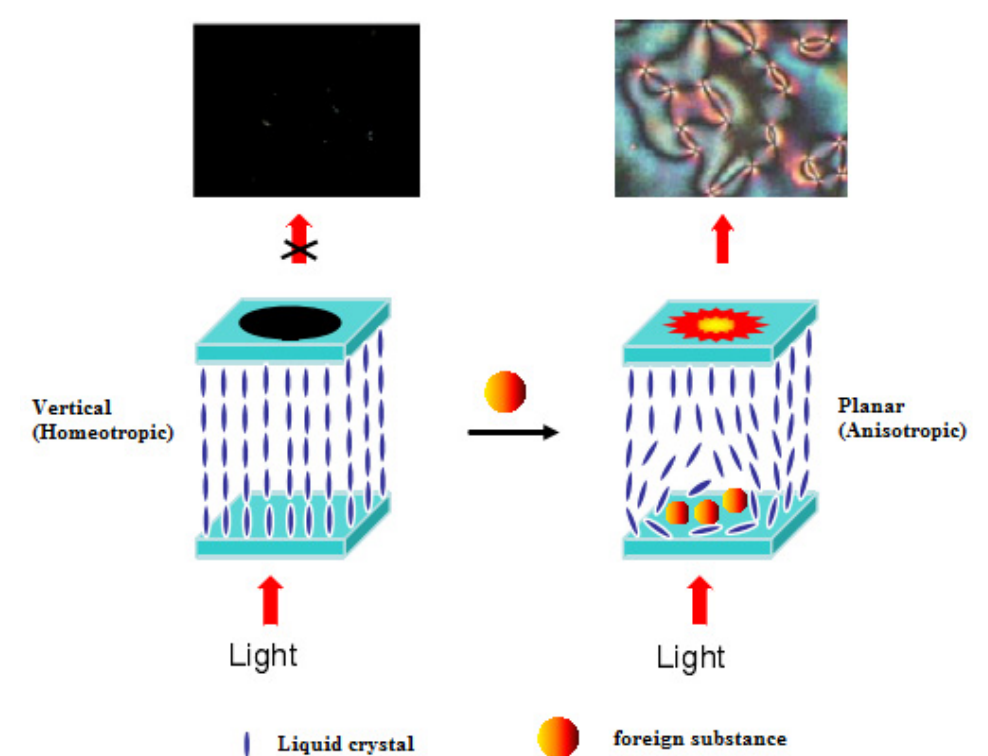
Figure 1. Schematic diagram of liquid crystal biosensor detection.